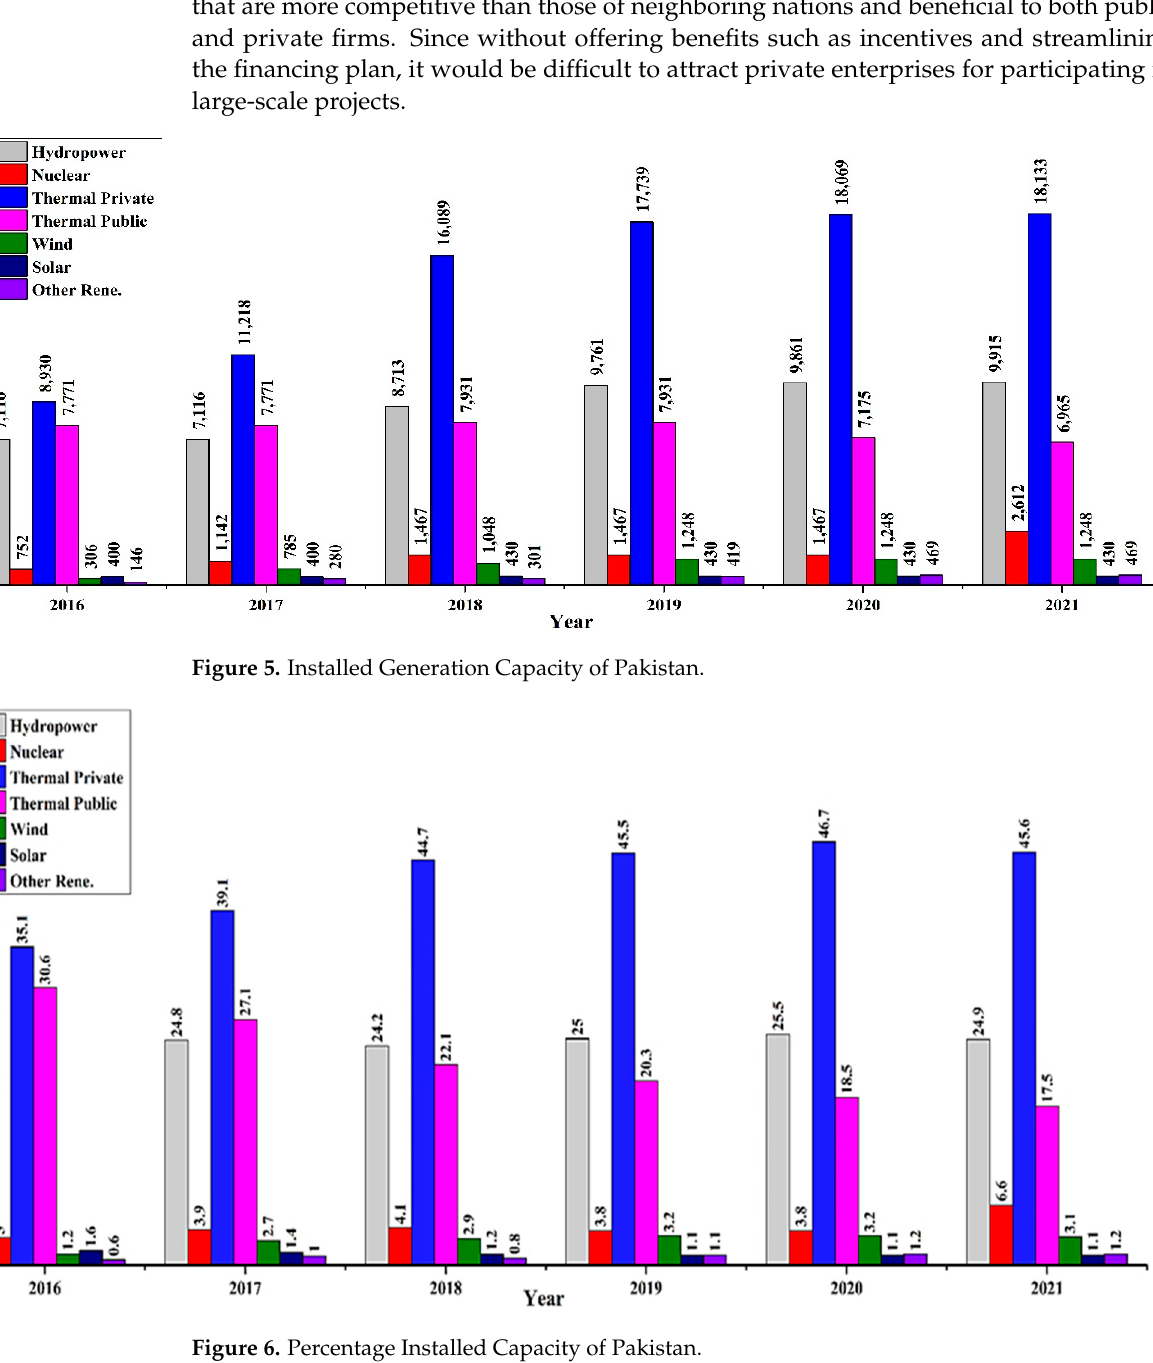
Figure 6 . Percentage Installed Capacity of Pakistan.